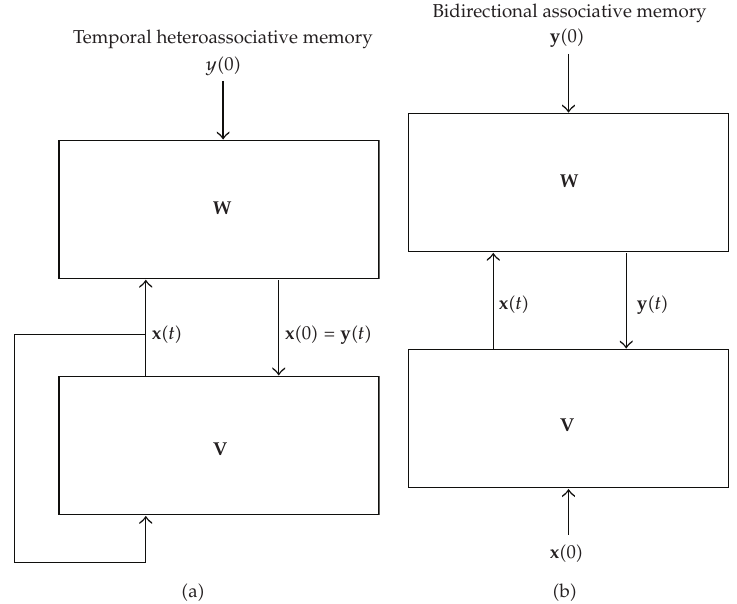
Figure 17: Comparison between the temporal associative memory and the standard